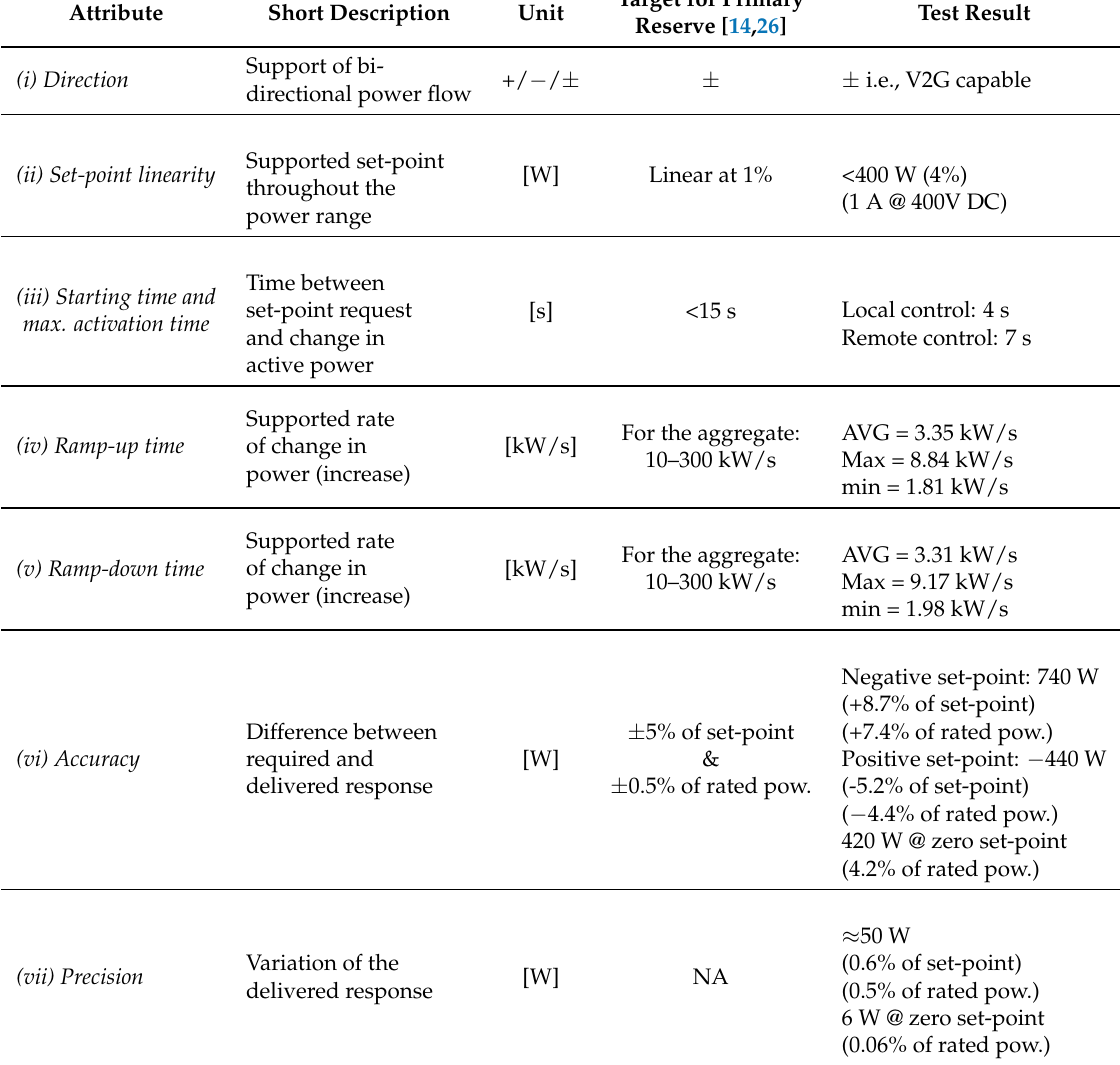
Table 2. Evaluation test